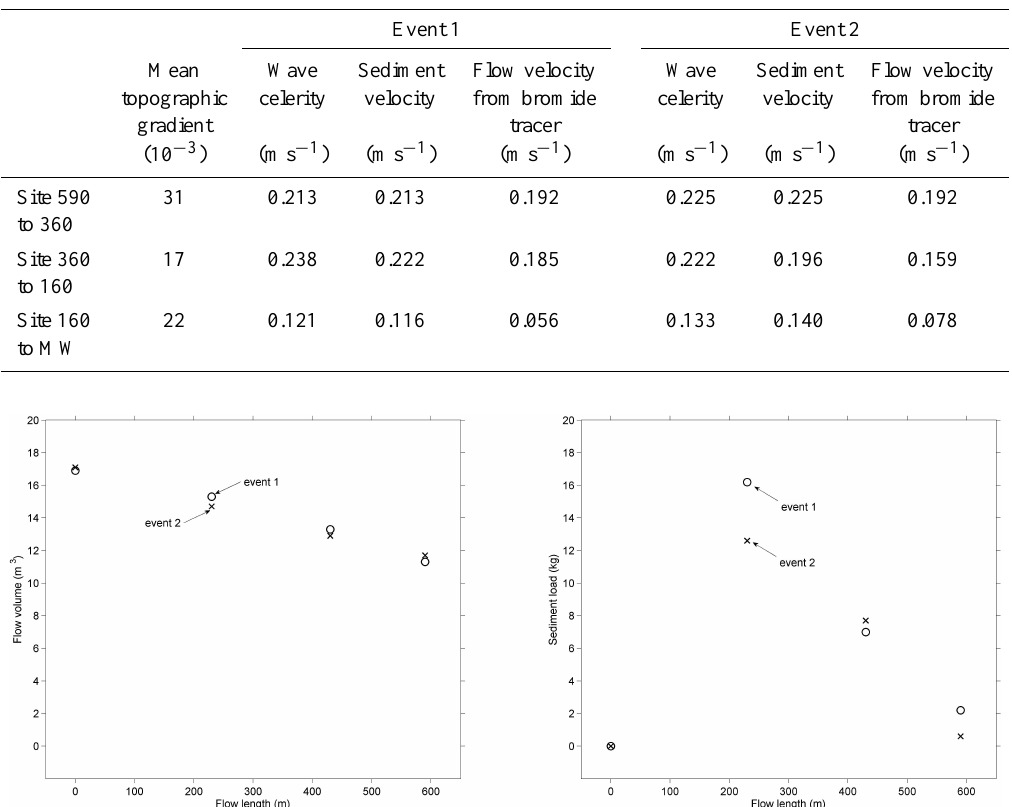
Table 1. Wave celerities estimated from the hydrograph dynamics, velocities of sediment transport estimated from the sedigraphs and flow velocities estimated from the bromide tracer samples. All estimates are for the first appearance (first rise) of the signal as in Fig. 9.